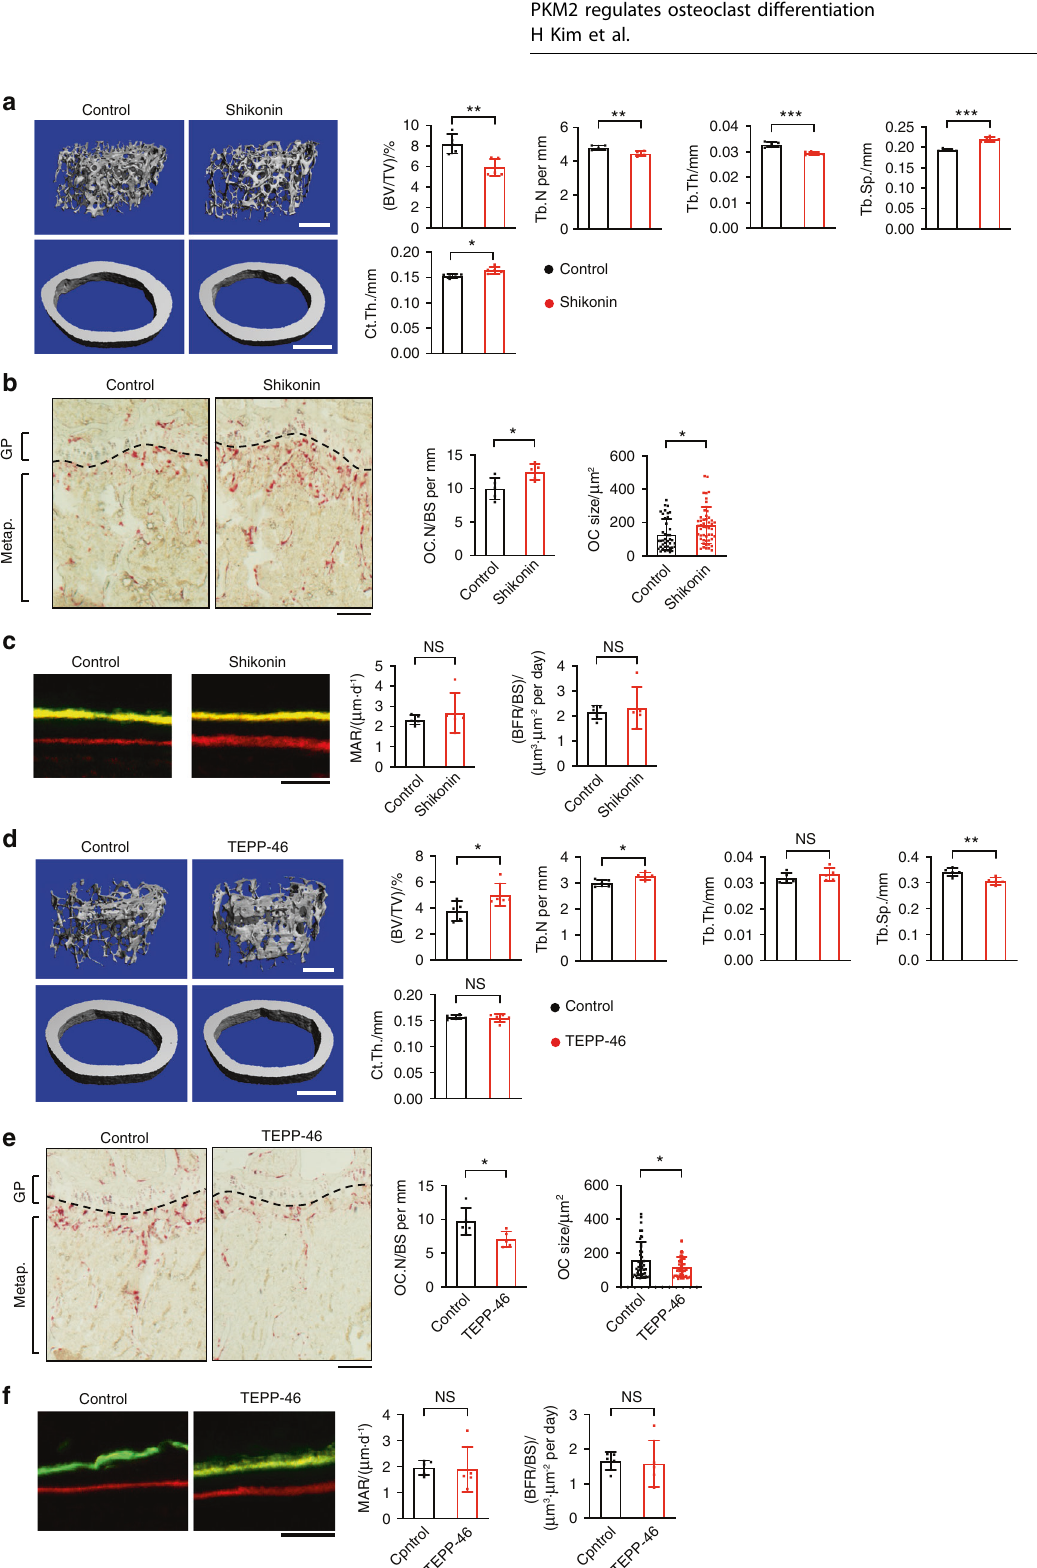
Fig. 4 Proper PKM2 activity is required for bone homeostasis. a , d Representative microcomputed tomography ( μ CT) images of femurs from mice treated with shikonin ( n = 5 mice per group) for 4 weeks ( a ) or TEPP46 ( n = 5 mice per group) for 6 weeks ( d ). Bone volume per tissue volume (BV/TV), trabecular thickness (Tb.Th), trabecular number (Tb.N), trabecular spacing (Tb.Sp), bone mineral density (BMD), and cortical thickness (Ct.Th) are shown. Scale bars represent 0.5 mm. b , e Representative TRAP staining images of the tibias of mice treated with shikonin for 4 weeks ( b ) or TEPP46 for 6 weeks ( e ). The scale bar represents 200 μ m. GP Growth plate, Metap. Metaphysis. c , f Representative dynamic histomorphometry of the tibias of mice treated with shikonin for 4 weeks ( c ) or TEPP46 for 6 weeks ( f ). The mineral apposition rate (MAR) and bone formation rate (BFR) are shown. The scale bar represents 50 μ m. Each dot represents the result of a single mouse ( n = 5 mice per group). Each dot in OC size represents the result of a single osteoclast. The data are presented as the means ±